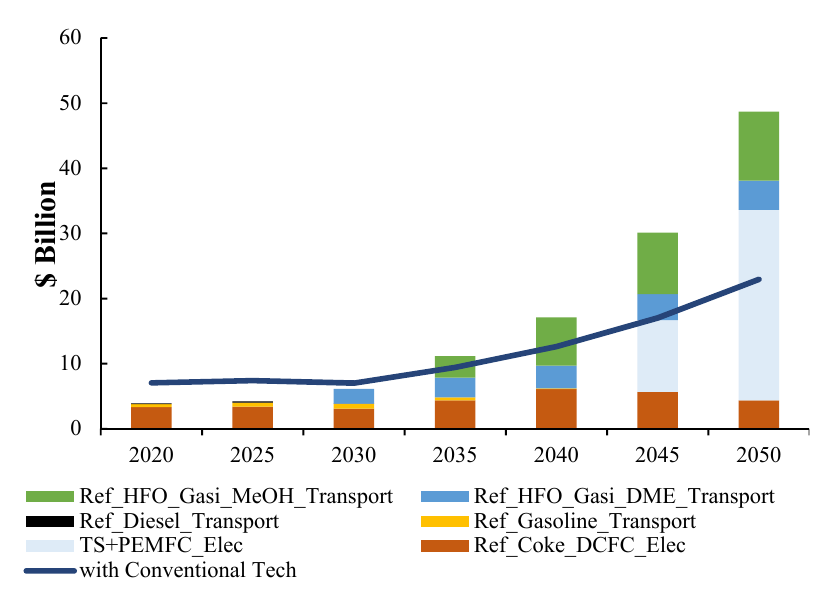
Figure 9. Investment requirements for scenario 2.